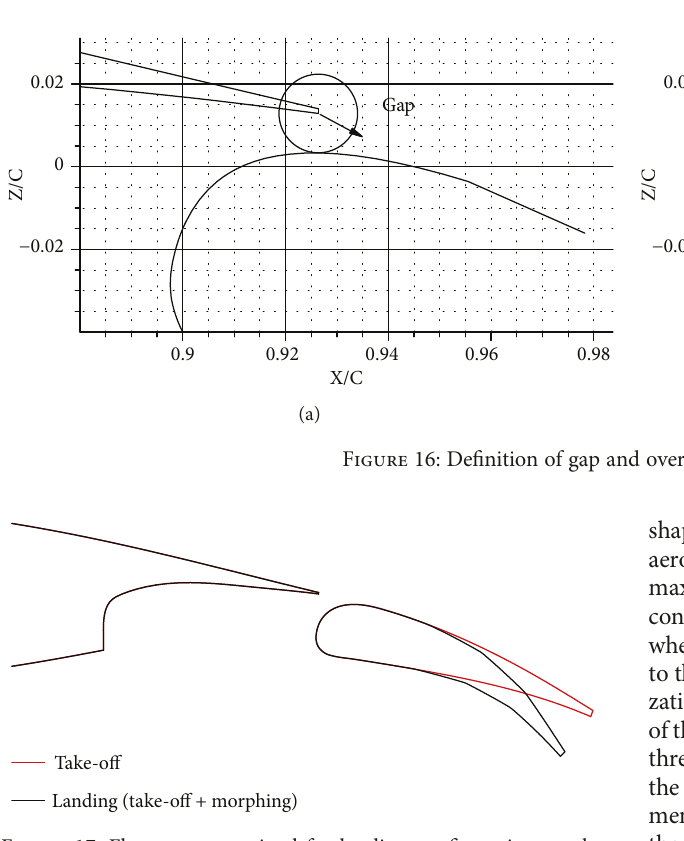
Figure 17: Flap system retained for landing con fi guration on the AG2-NLF